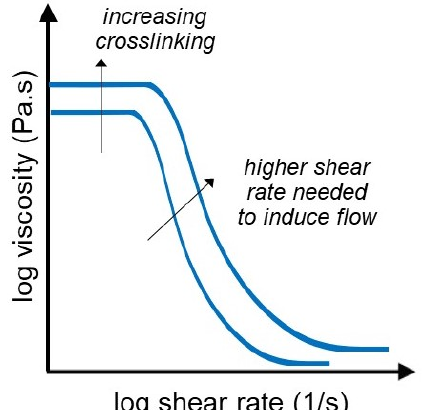
Figure 3. Schematic graph showing the flow behavior of hydrogels, represented by viscosity as a function of shear rate.